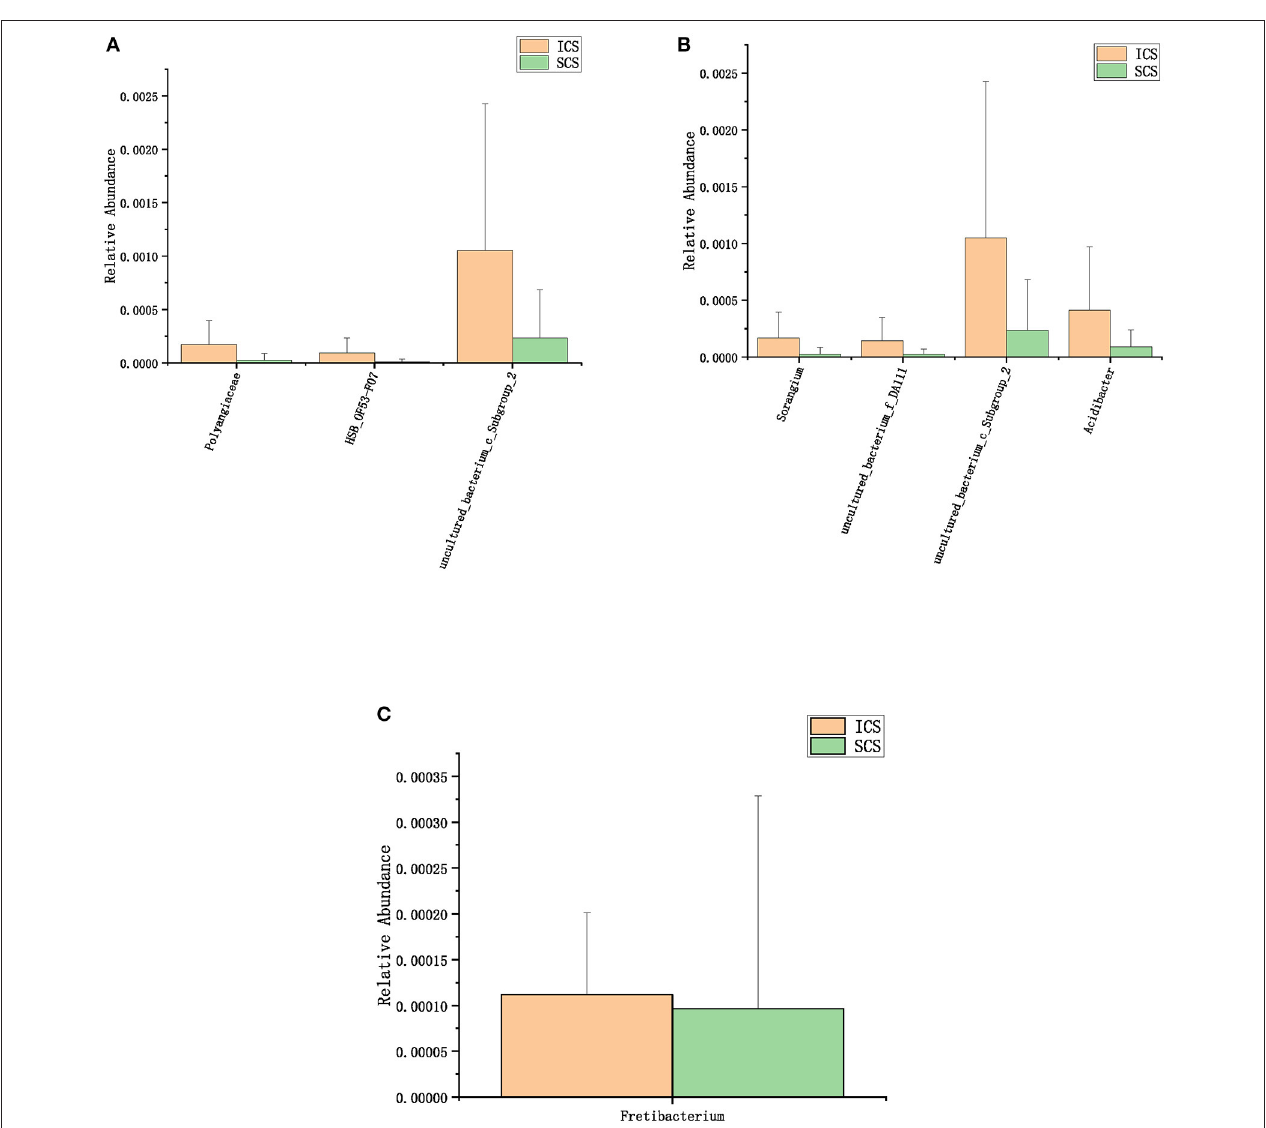
FIGURE 5 | Colonies with different abundances after 7 days of treatment. (A) One-way analysis of variance (ANOVA) at the family level. (B) Calculated by ANOVA at the genus level. (C) Calculated by Wilcoxon test at the genus level ( p < 0.05).